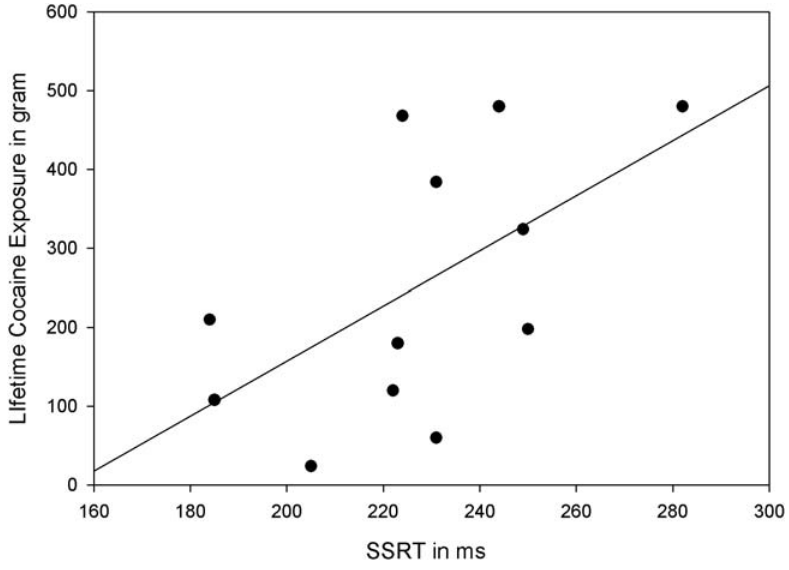
Figure 2. Scatter diagram of individual lifetime cocaine exposure (in gram) against SSRT (in ms).